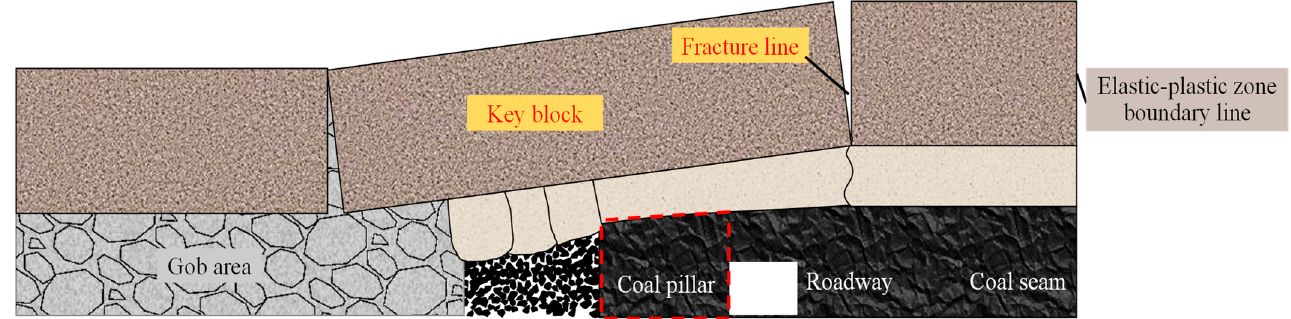
Figure 14. Structural mechanics model of gob-side entry driving [52].